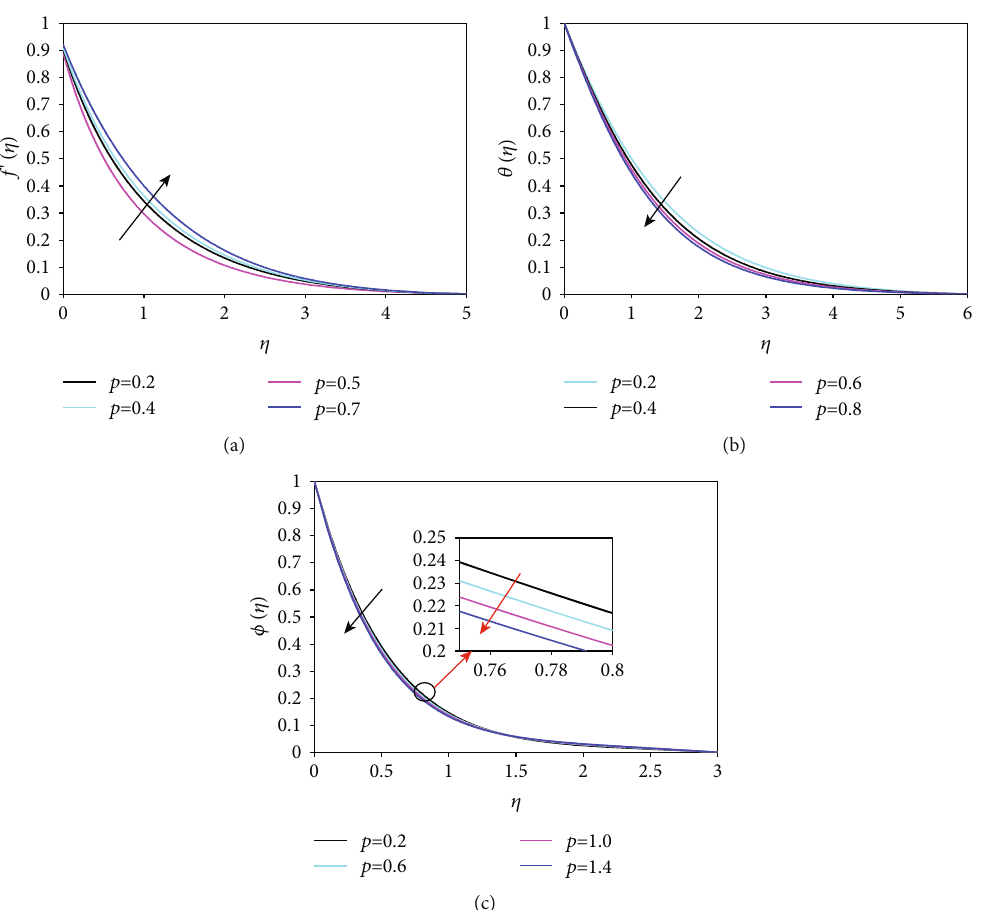
Figure 8: The graph of velocity, temperature, and concentration for di ff erent values of temperature buoyancy parameter ( p